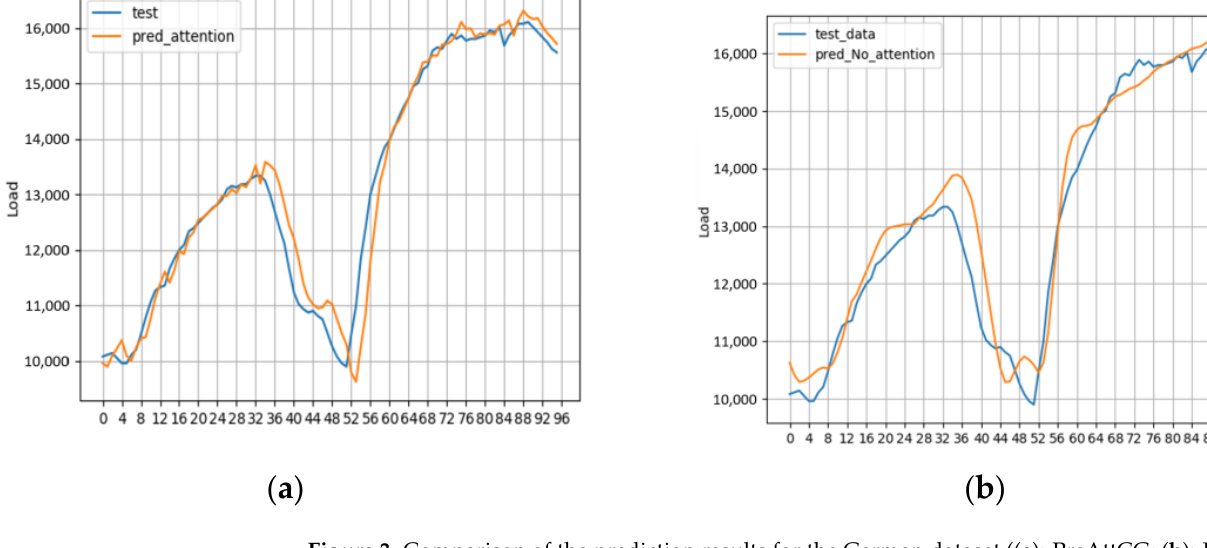
Figure 3. Comparison of the prediction results for the German dataset (( a ): PreAttCG; ( b ): LSTM).